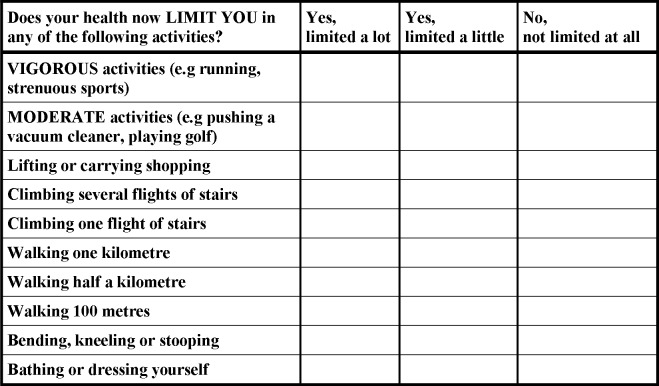
Questions included in the Medical Outcomes Study–Physical Functioning (MOS-PF) scale.